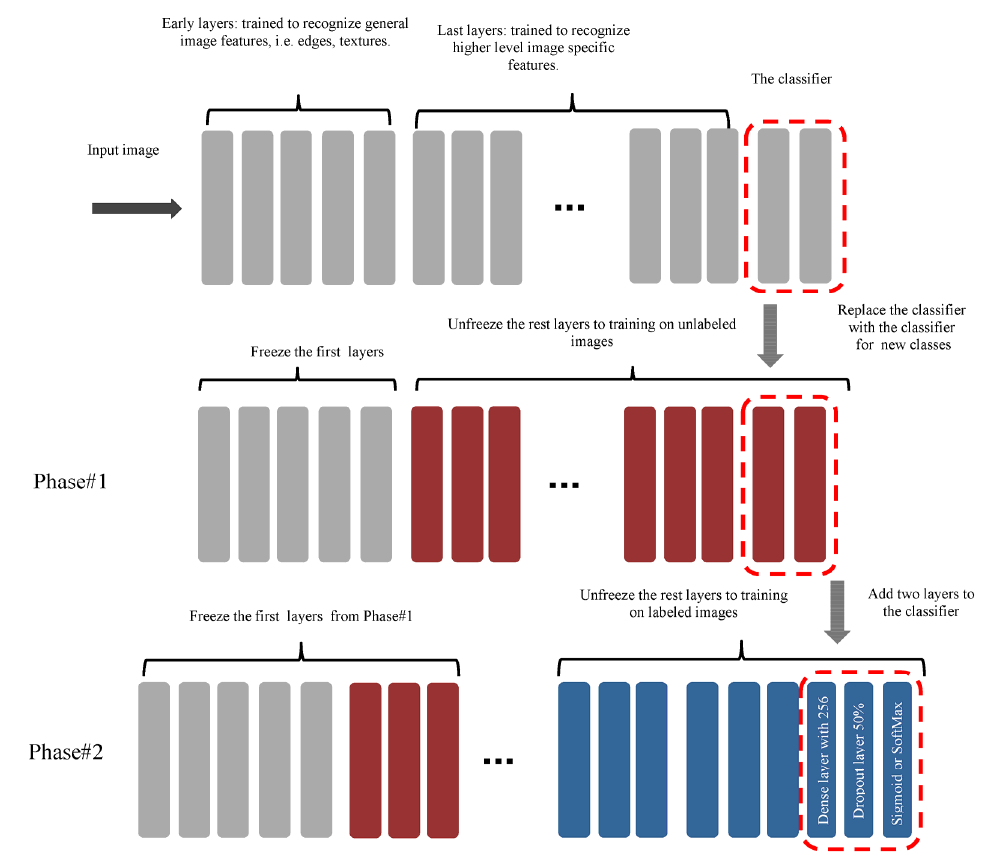
Figure 11. Proposed modification on the models.